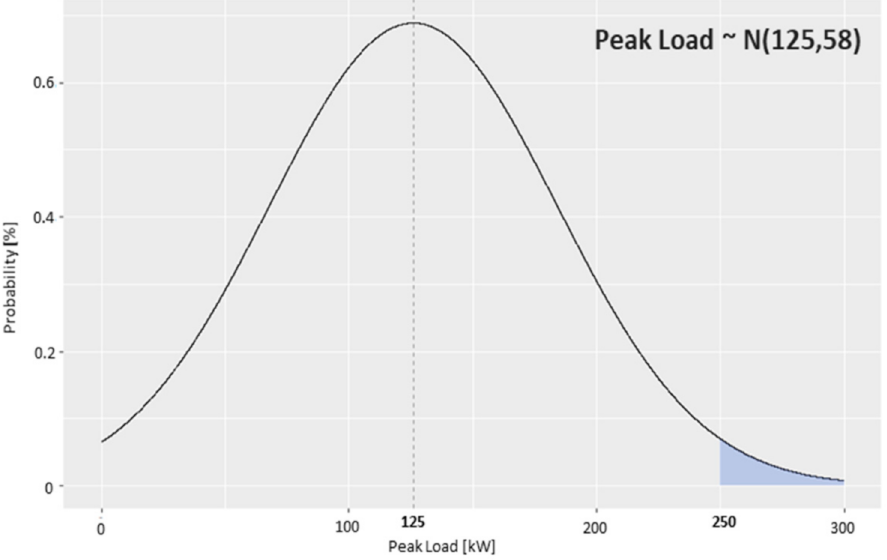
Figure 5. Peak management range